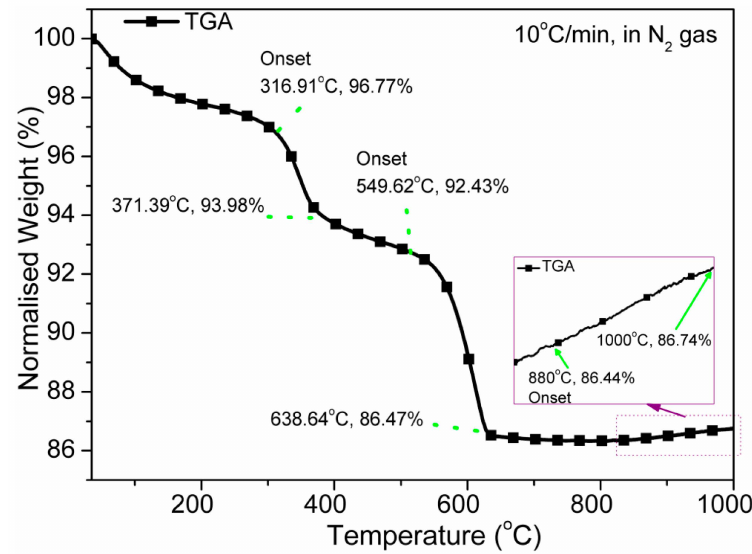
Figure 2. Thermogravimetric analysis (TGA) of unsintered powder from 35 to 1000 ˝ C (ramp: 10 ˝ C/min, atmosphere: nitrogen gas). Three onset and offset points are presented. The weight-loss is obtained up to 800 ˝ C, beyond that there is a little gradual weight